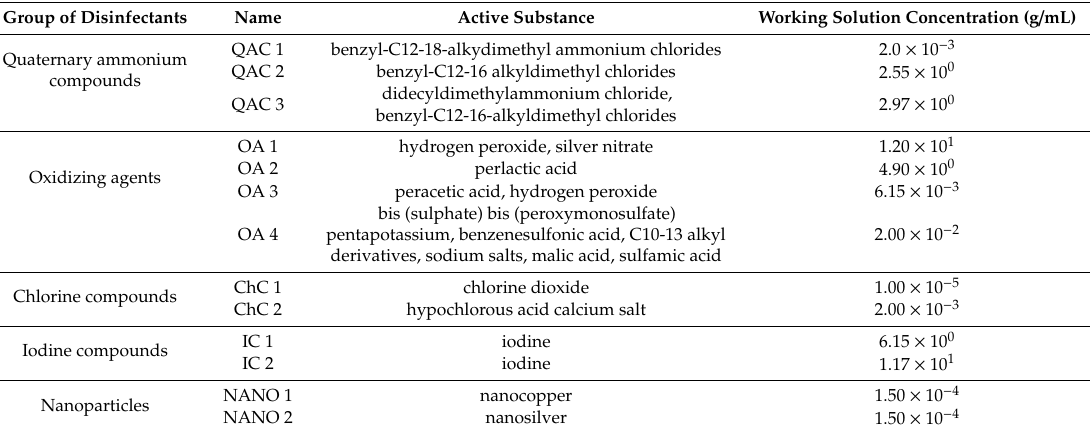
Table 1. Characteristics of